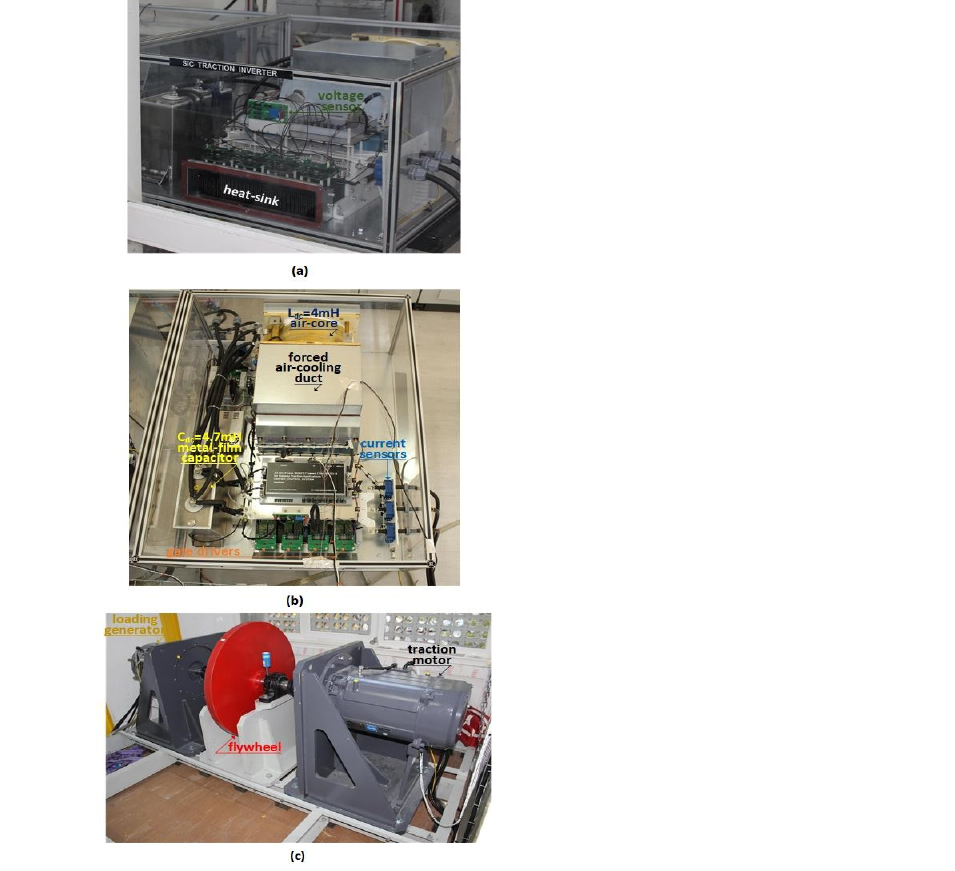
Figure 9. The developed all-SiC power MOSFET-based traction converter. ( a ) Front view, ( b ) top view, and ( c ) traction motor-loading generator set.